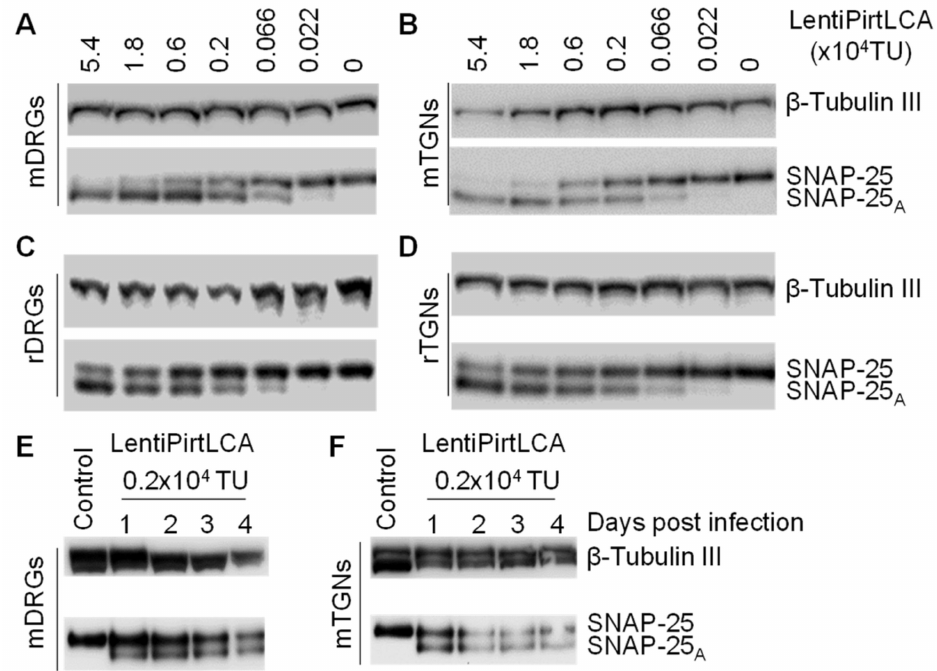
Figure 3. LentiPirtLCA yielded rapid and concentration dependent SNAP-25 cleavage in the infected sensory neurons. Cultured mDRGs ( A ), mTGNs ( B ), rat DRGs (rDRGs) ( C ) and rat TGNs (rTGNs) ( D ) were infected with lentiPirtLCA with the indicated doses for 5 days before probing the SNAP-25 cleavage. Western blots revealed lentiPirtLCA dose-dependently cleaved SNAP-25 in both DRGs and TGNs. mDRGs ( E ) and mTGNs ( F ) were incubated with lentiPirtLCA with the indicated dose for 24 h. Cells were either immediately harvested in LDS-sample buffer or continually cultured until the indicated time points before harvesting for probing the SNAP-25 cleavage. Control samples in ( E , F ) were virus-free samples at day